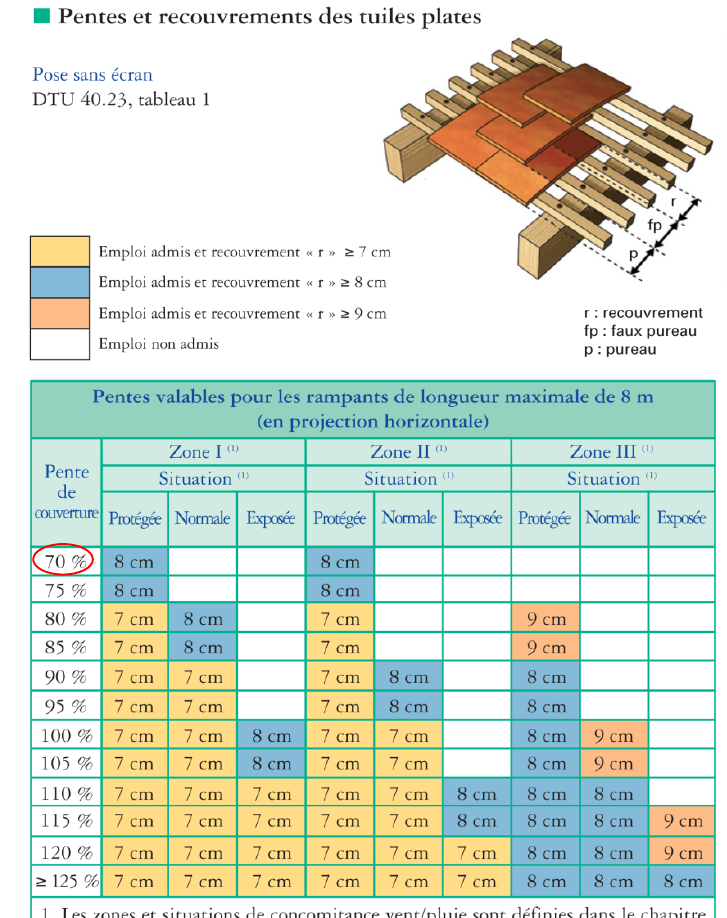
Figure 3. Extract of Technical Guide (TG) “The tile